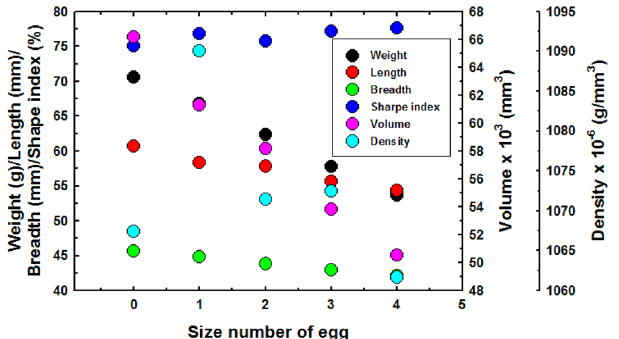
Figure 9. Relationship between egg size with the means of weight, length, breadth, shape index, volume and density of the eggs at the time of maximum freshness.